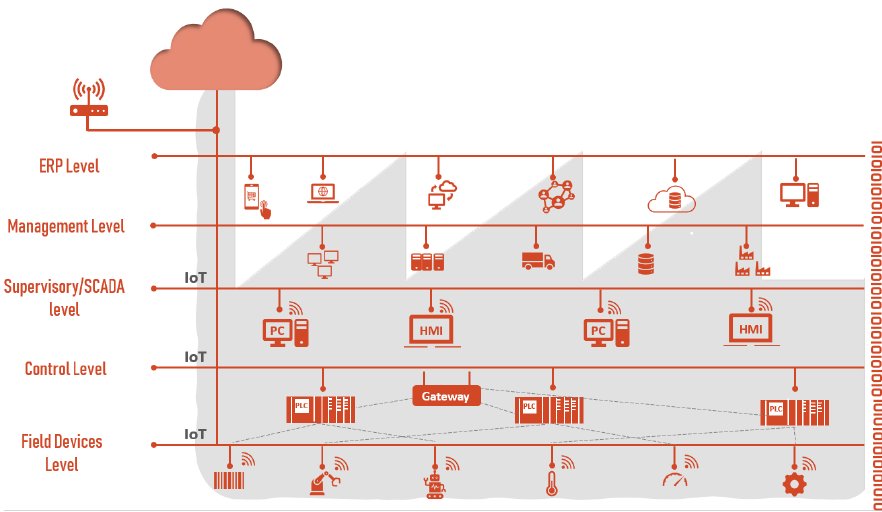
Figure 2. The architecture of a smart factory in an intelligent automation